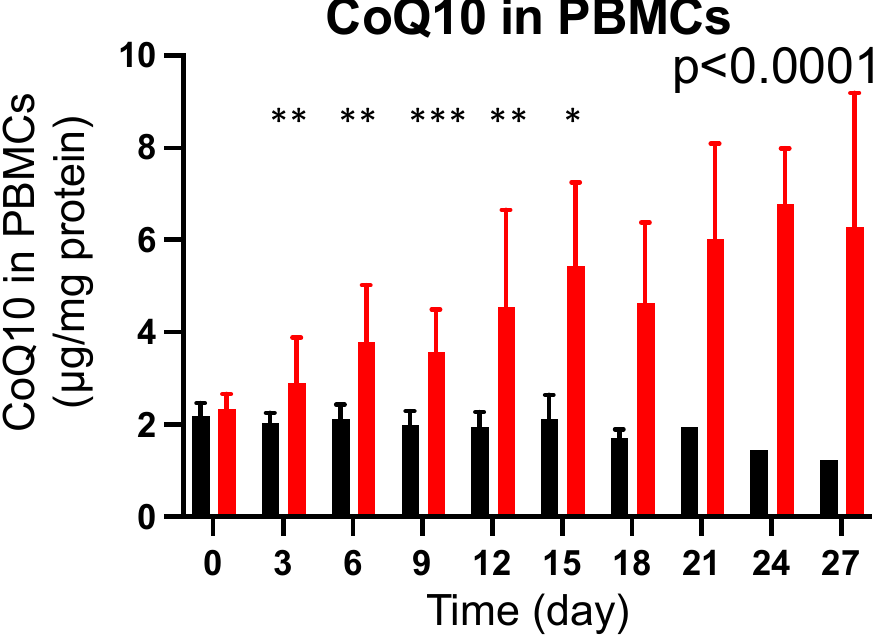
Figure 3. Effects of CoQ10 supplementation on total CoQ10 content in PBMCs in burn patients. CoQ10 supplementation significantly increased total CoQ10 content in PBMCs compared with the placebo group. The p value in the figure indicates overall difference between the groups across the different time points that was analyzed using a longitudinal general linear mixed-effects model. The asterisks indicate p values between the groups at each time point, which were analyzed by Bonferroni’s multiple comparison test. Black bar: Placebo, Red bar: CoQ10, * p < 0.05, ** p < 0.01, *** p < 0.001 vs. Placebo.